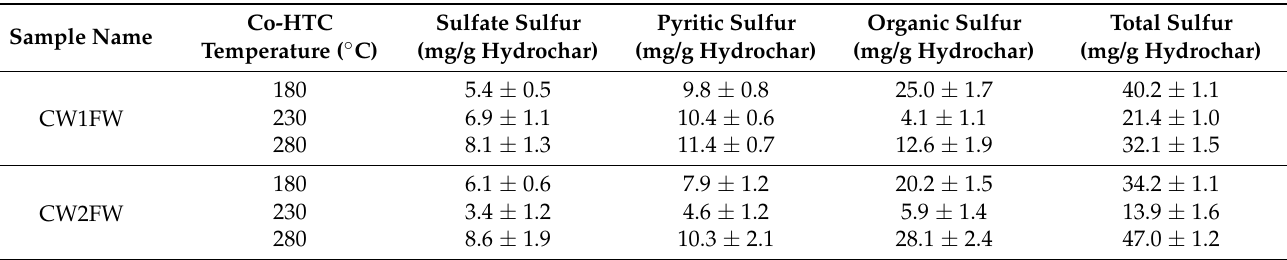
Table 1. Change of different forms of sulfur content with Co-HTC of FW and CW at various Co-HTC